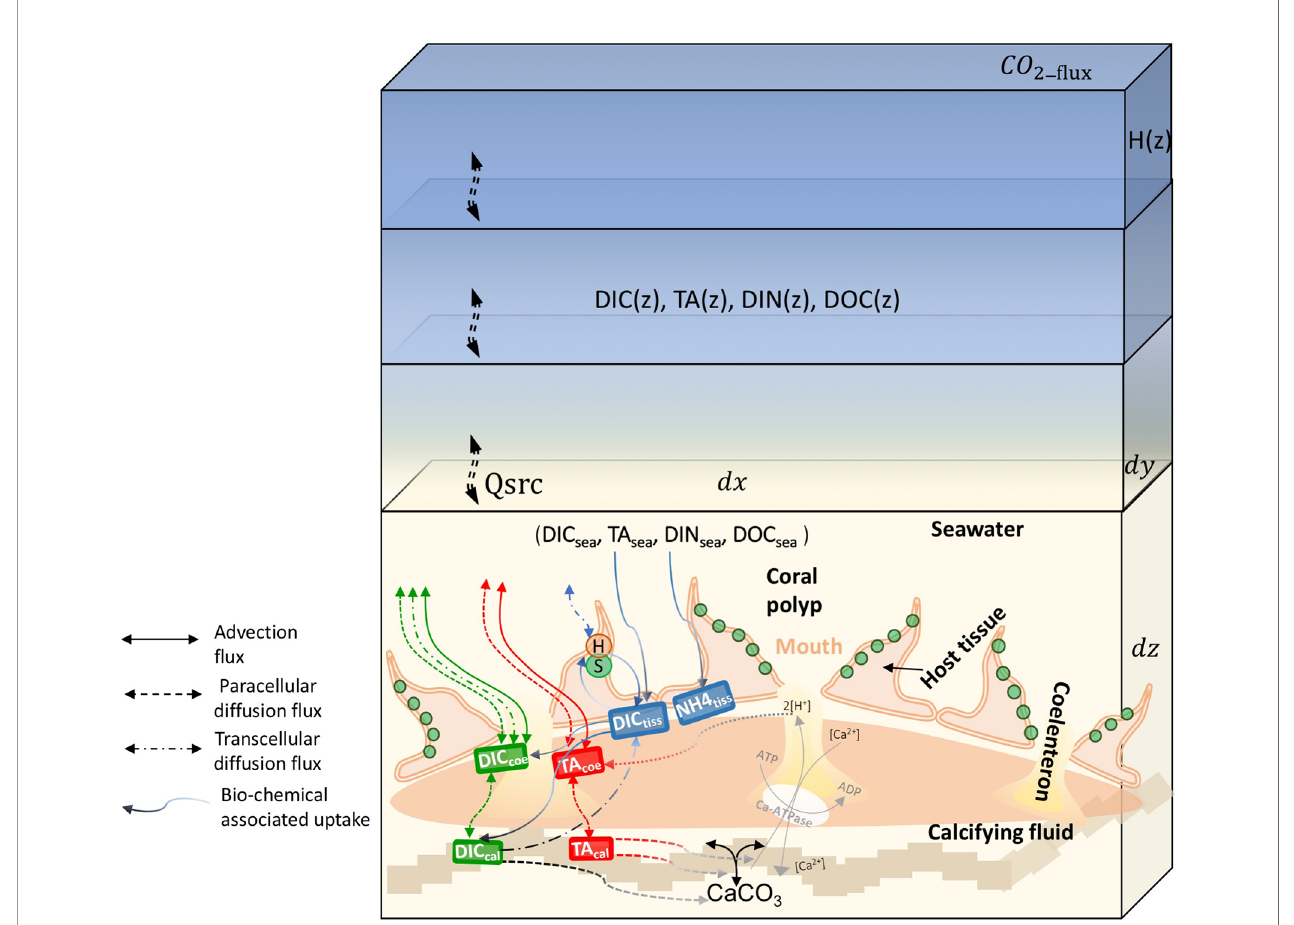
FIGURE 2 | Schematic showing the coupling of the coral polyp model with the biogeochemical model grids. The coral lies on the bottom grid of the hydro- biogeochemical model. The green dots indicate symbiont (zooxanthellae) which live in coral polyp. The dx and dy refer to the biogeochemical model grid size along the x and y axes; H(z) is the height of a grid; DIC(z), TA(z), and DIN(z) indicate concentration in each grid; Q src indicates the point of source terms (DIC, DIN, TA, and DOC) in the biogeochemical model at the bottom grid; and CO 2- fl ux is the fl ux that exits between the air and the ocean at the surface grid of the biogeochemical model. The four components of polyp model (seawater, host tissue, coelenteron, and calcifying fl uid) are denoted. The arrow lines denote major fl uxes between them as listed in Tables 4 , 5